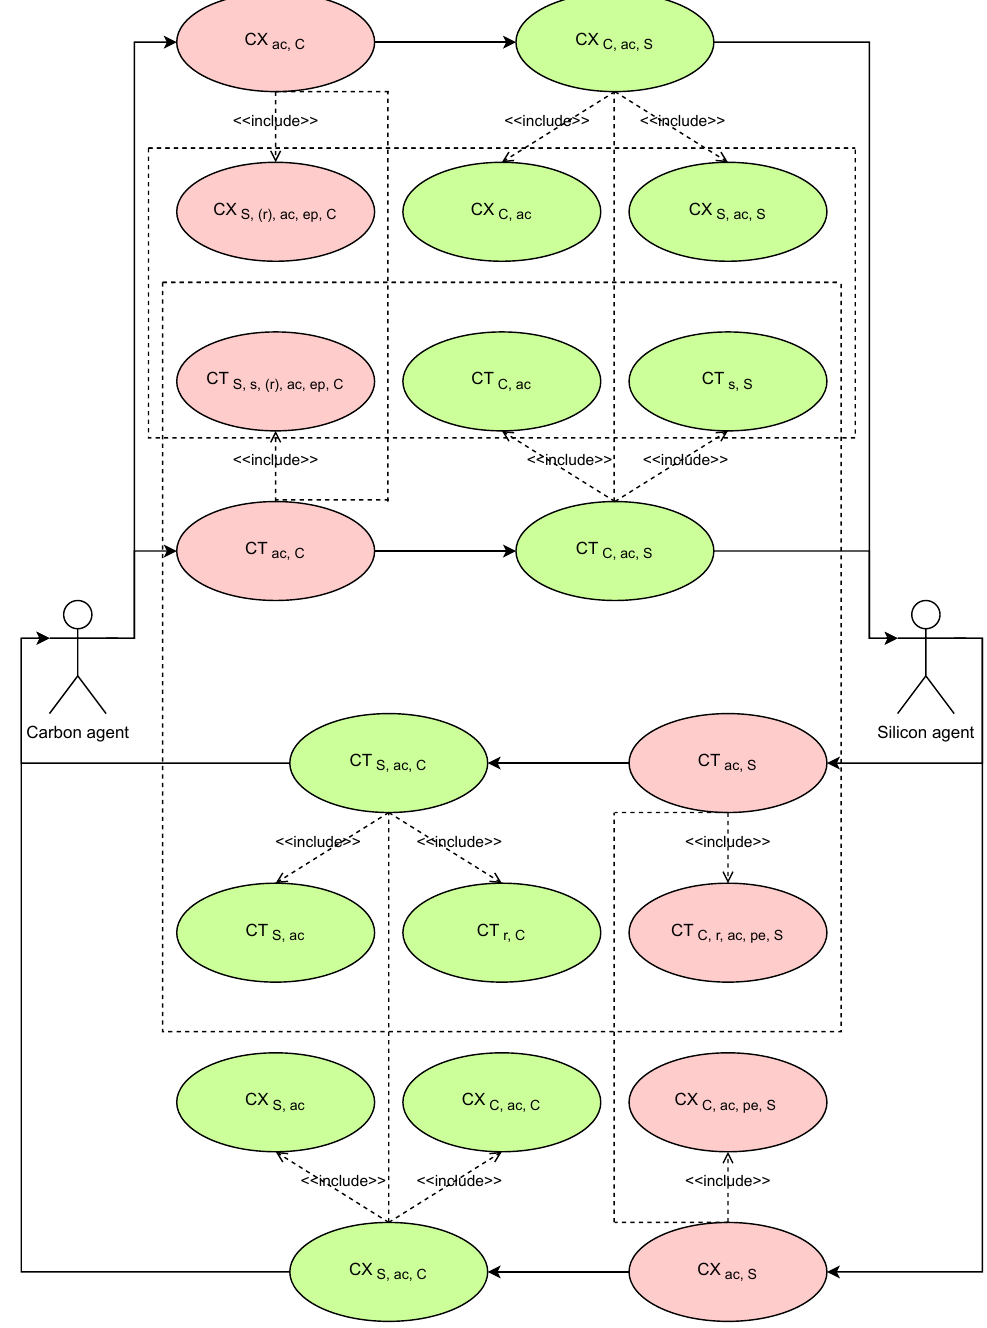
Figure 2. Carbon–silicon (CS) info-communication